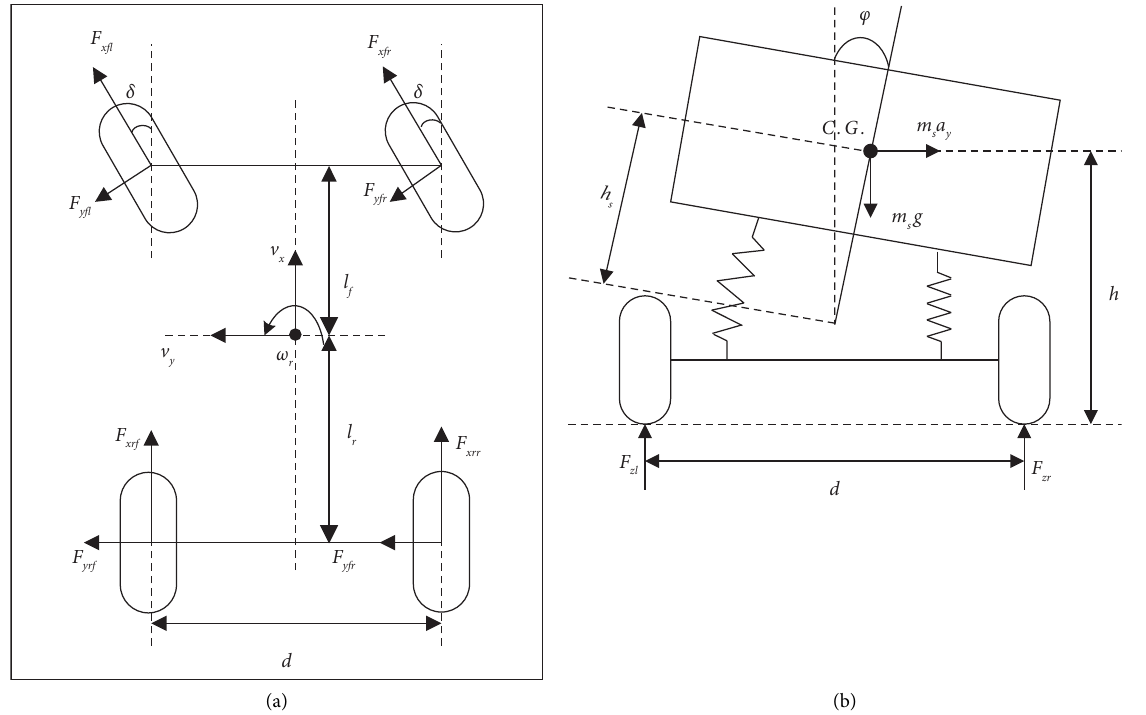
Figure 1: 3-DOFs vehicle dynamics model. (a) Lateral model. (b) Roll